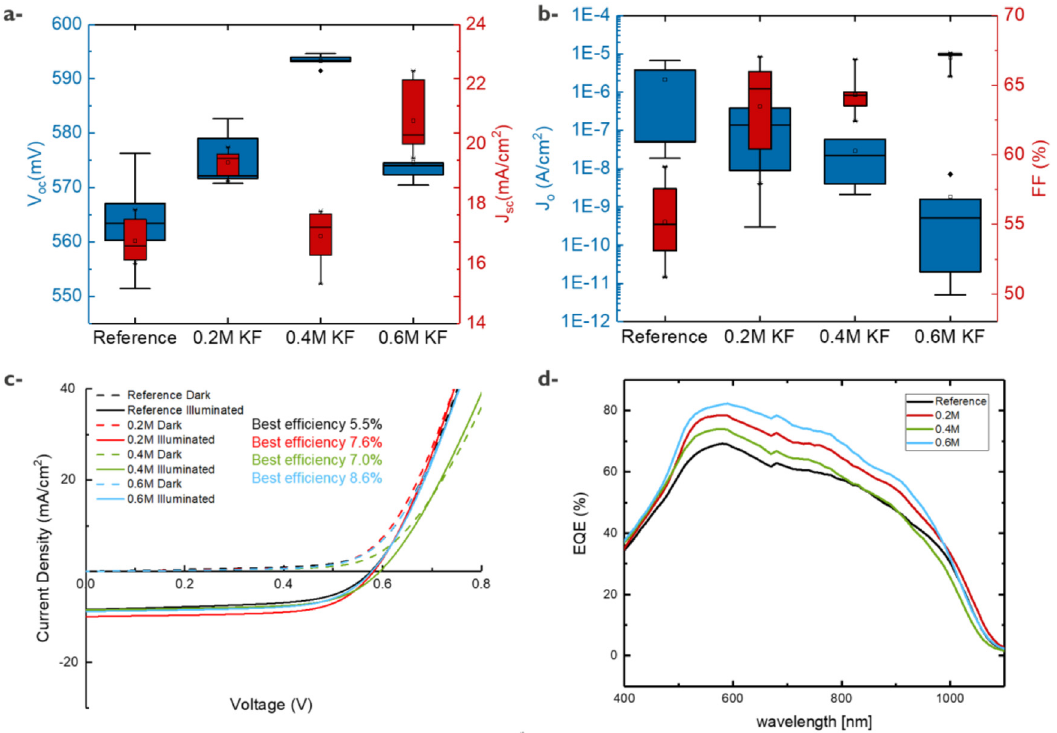
Fig. 4. J-V parameter comparison between reference (bare) and passivated ultrathin CIGS solar cells: (a) Voc (left axis) and Jsc (right axis), (b) J 0 (left axis) and FF(right axis), (c) J-V curves with best ef fi ciency values and (d) EQE responses for different KF molarity with 2nm thick HfO x